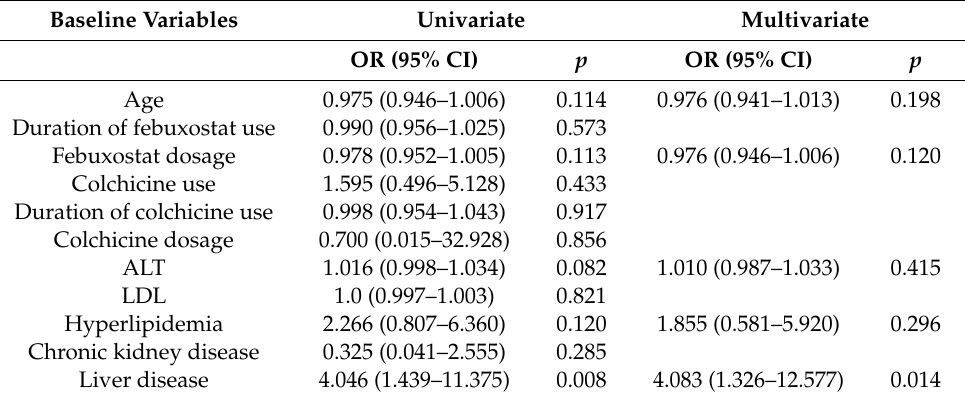
Table 3. Risk factors for hepatotoxicity in gout patients on